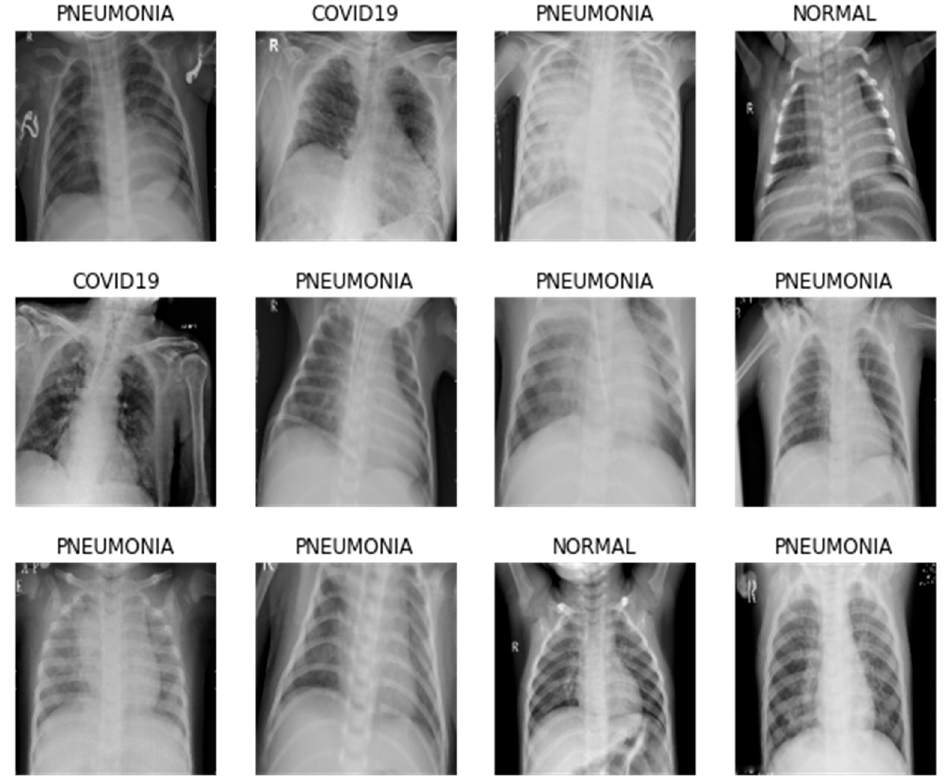
Figure 1. Examples of healthy, pneumonia, and COVID-19 chest X-ray images.